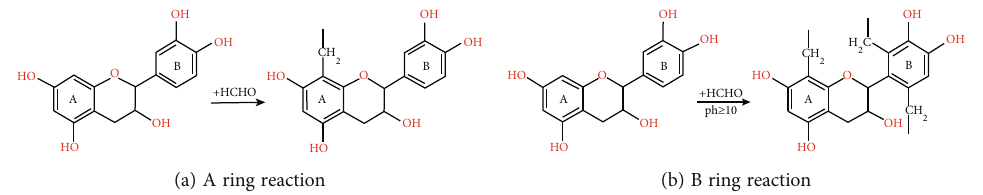
Figure 19: The reaction formula of tannin and formaldehyde. Table 4: Erosion resistance performance evaluation test results.